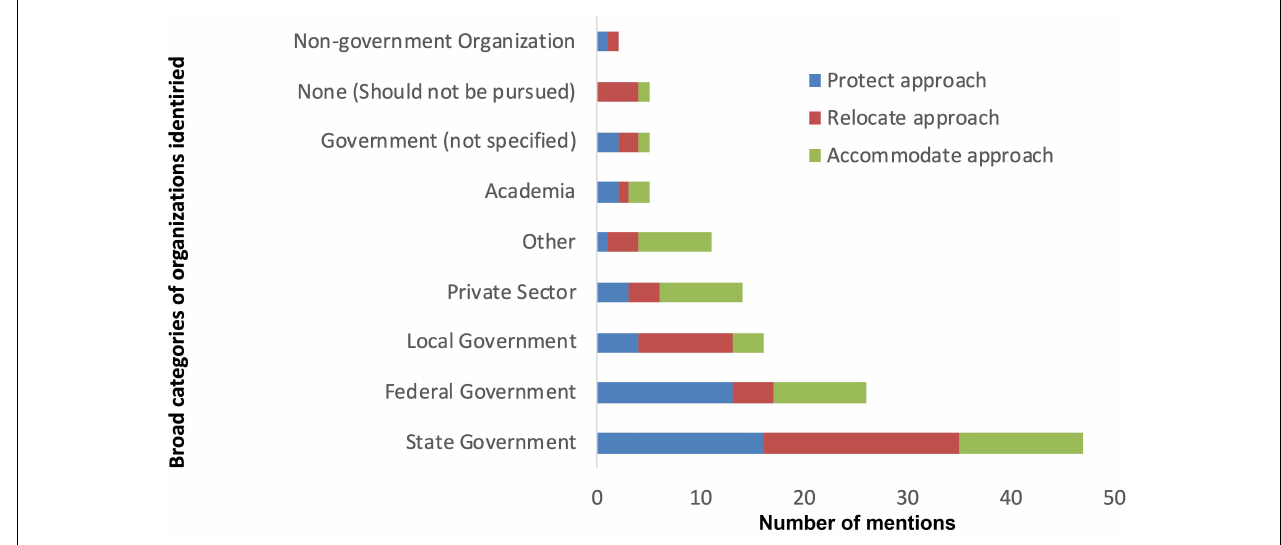
FIGURE 6 | Broad categories of organizations mentioned by respondents ( n = 25 respondents and 131 total